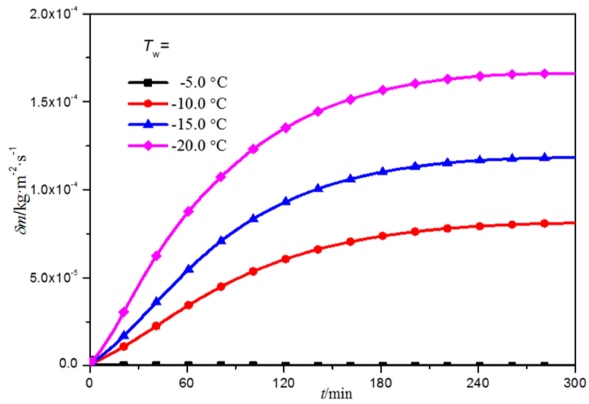
Figure 7. Variation of frost crystal deposition rate over time at different cold surface